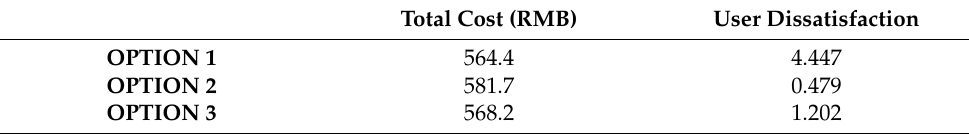
Table 3. Optimization scheduling results under different